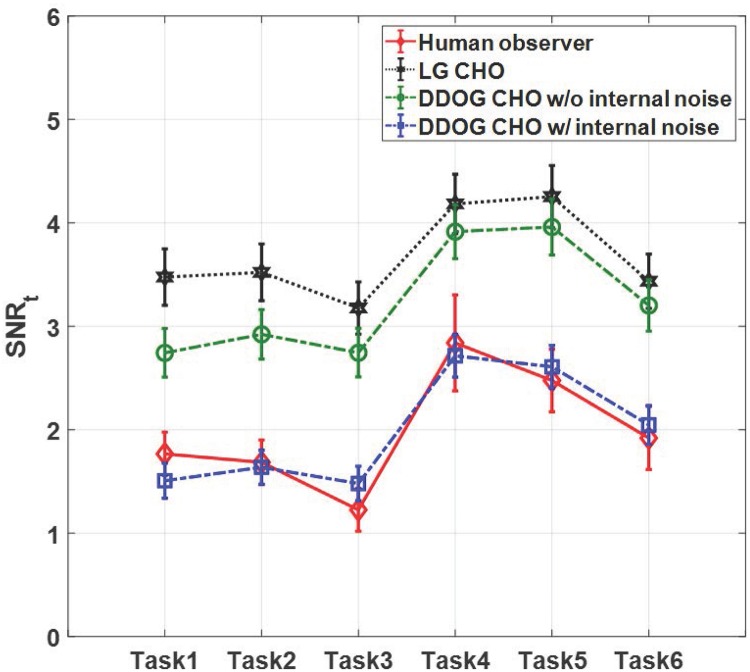
SNRt values of human and model observers.The SNRt values of the human and model observers with 95% confidence intervals for all tasks.